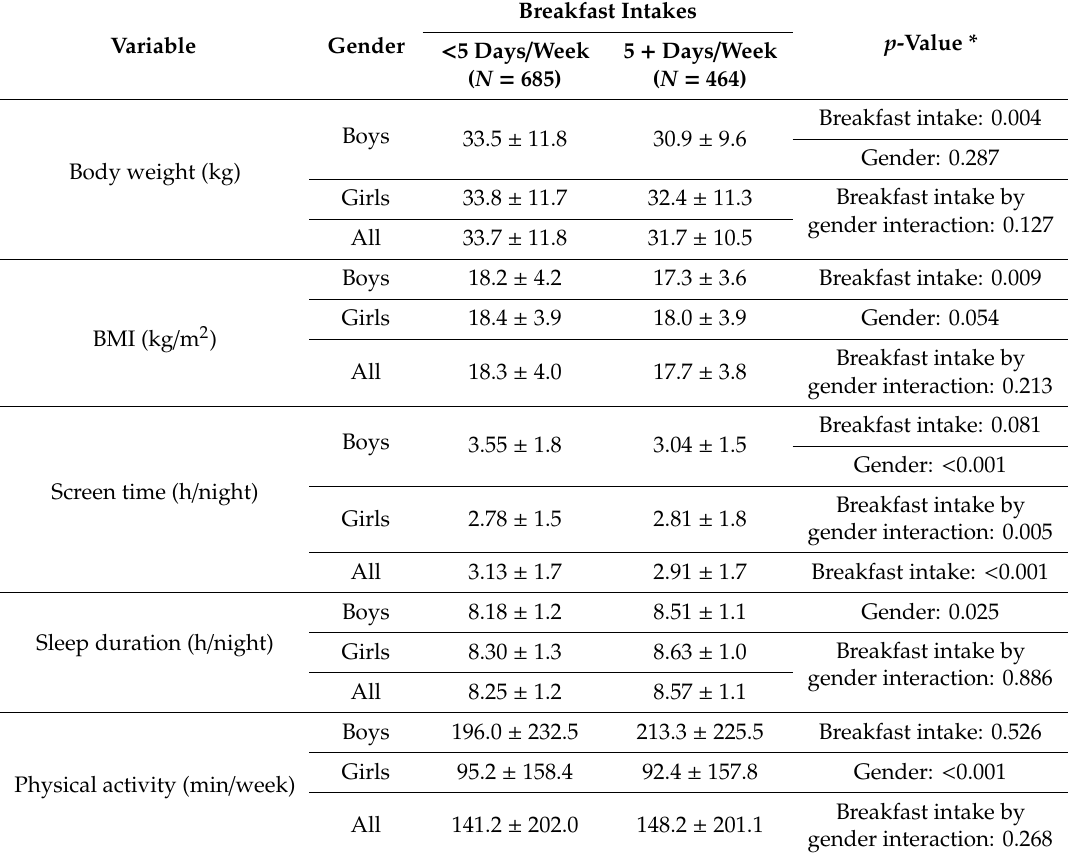
Table 7. Multivariate analysis for selected anthropometric and lifestyle variables while controlling for age and socio-demographic factors stratified by gender and breakfast intake frequency. Data are means and standard